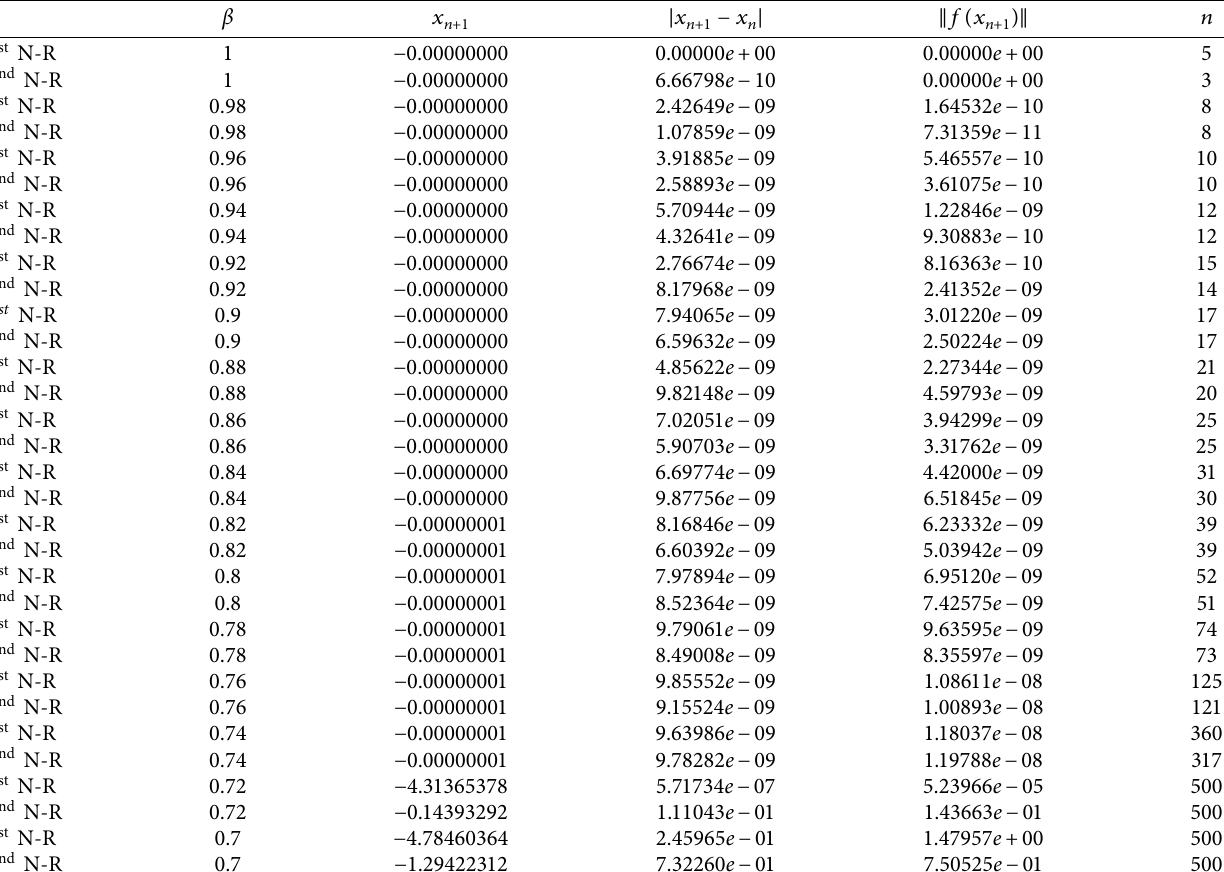
( x ) with Caputo derivative and initial estimation x 2